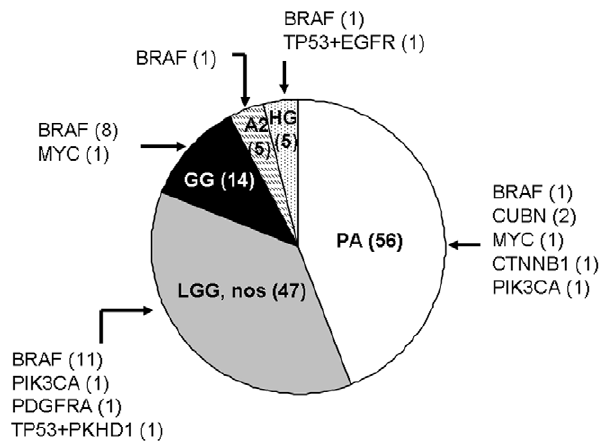
Figure 2. BRAF V600E mutations detected in archival samples of pediatricgliomas. Abbreviations:PA-pilocyticastrocytoma,WHOgradeI; LGG, nos – low-grade glioma, not otherwise specified, WHO grade I or II; GG – ganglioglioma; A2 – astrocytoma, WHO grade II; HG – high-grade glioma, WHO grade III or IV. Parentheses indicate total number of samples (in chart) ornumberof samples with indicated mutation(outside chart).